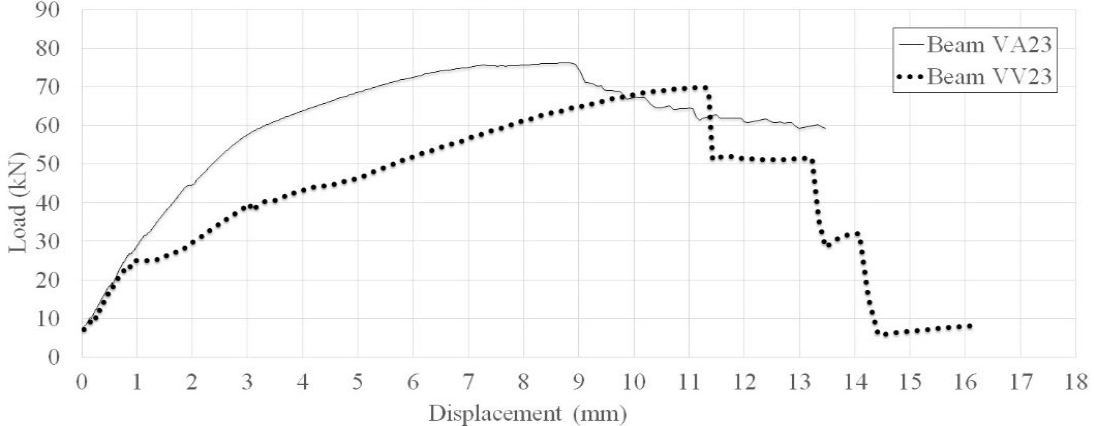
Figure 5. Load vs displacement curves of the 23.5 kN beams.